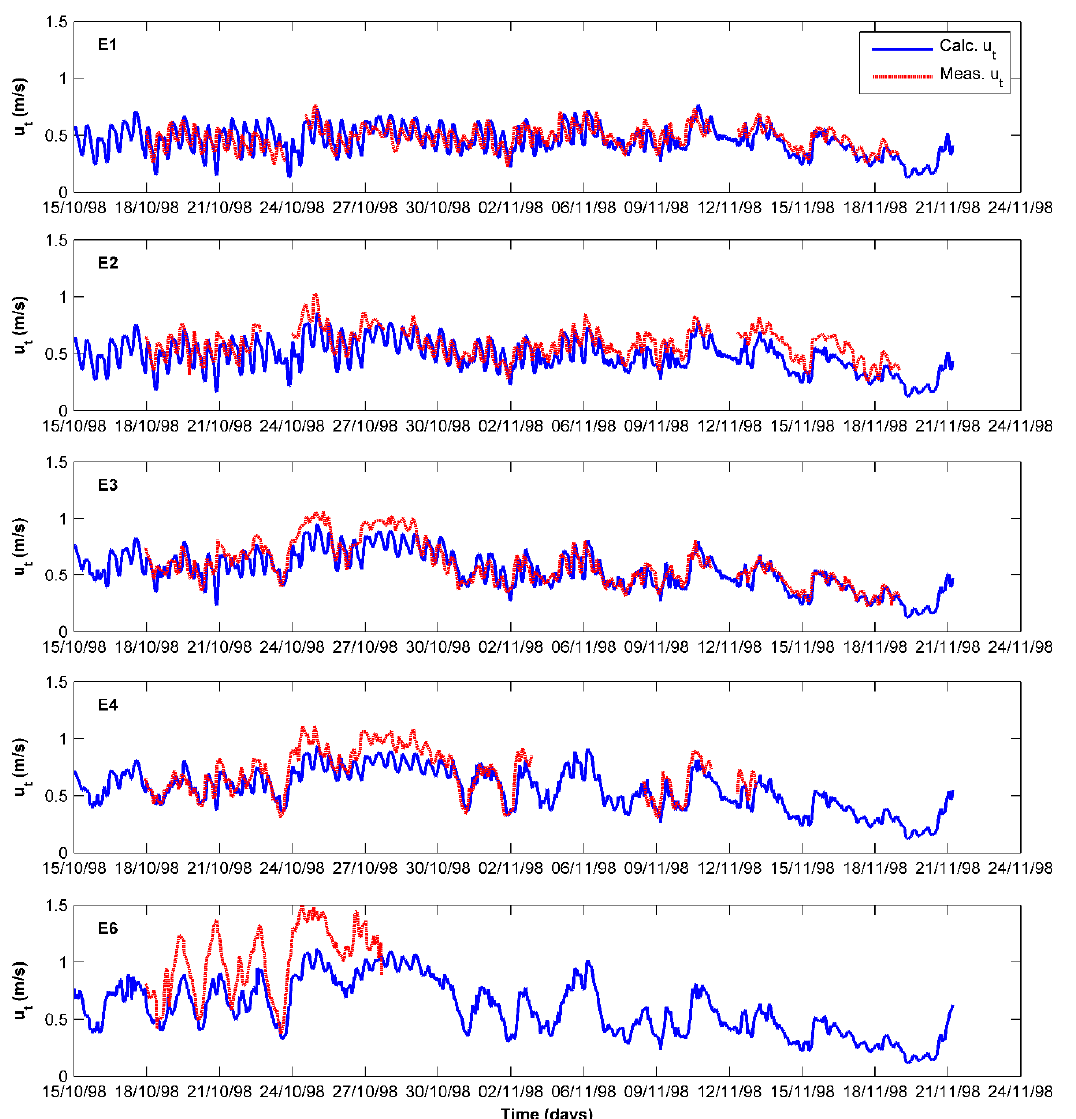
Figure 8. Calculated and measured peak offshore orbital velocity at Egmond Beach. Table 3. Quantitative assessment of formula performances for the Egmond data.